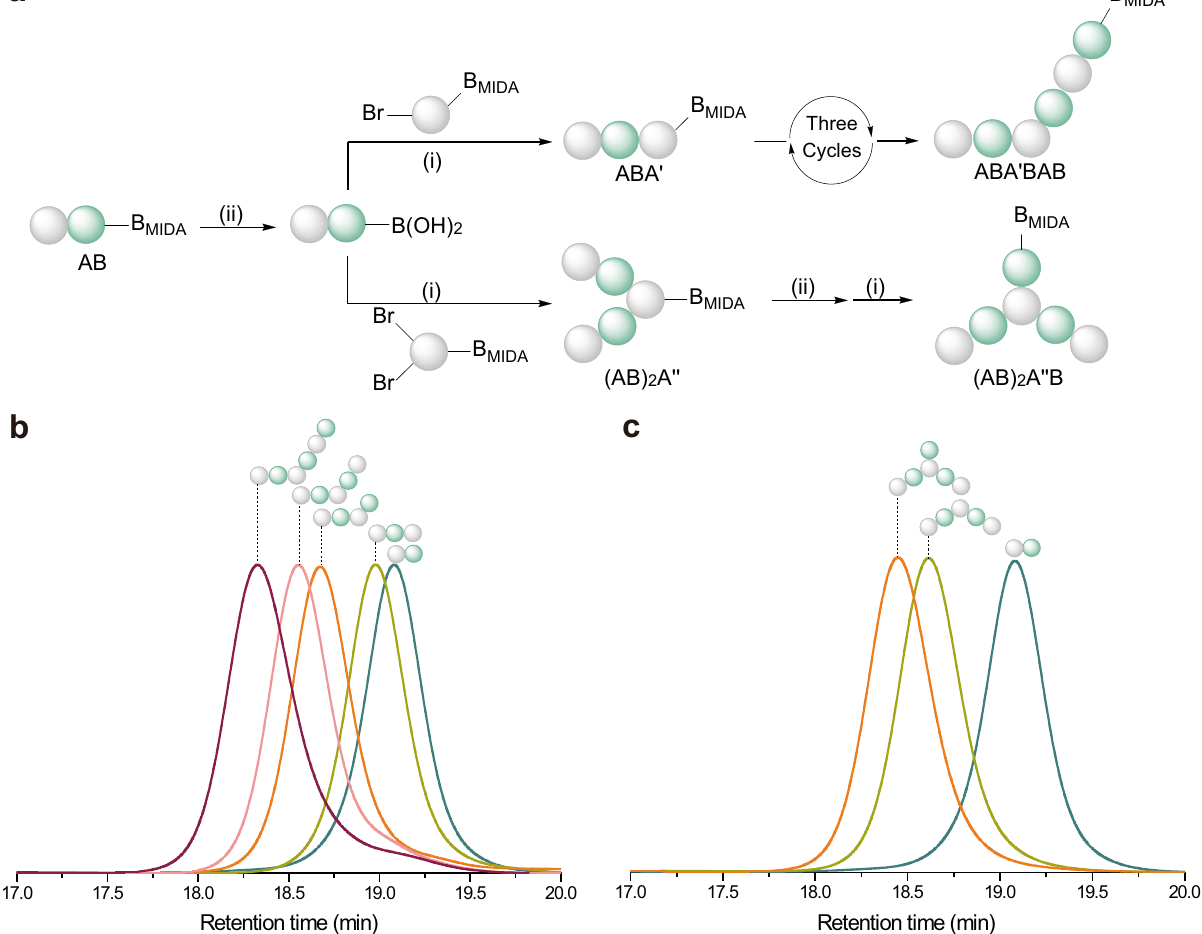
Fig. 4 Synthesis and characterization of alternating oligomers with topological variations (ABA ′ BAB and (AB)2A ″ B). a Sequential approach for the synthesis of hexamers ABA ′ BAB and (AB) 2 A ″ B based on AB-sequenced oligomer. (i) Suzuki coupling reaction (Pd(OAc) 2 , RuPhos, anhydrous THF, 70 °C); (ii) hydrolysis reaction (THF/NaOH aqueous solution). b GPC traces of each product in the synthesis of ABA ’ BAB. c GPC traces of each product in the synthesis of (AB) 2 A ″